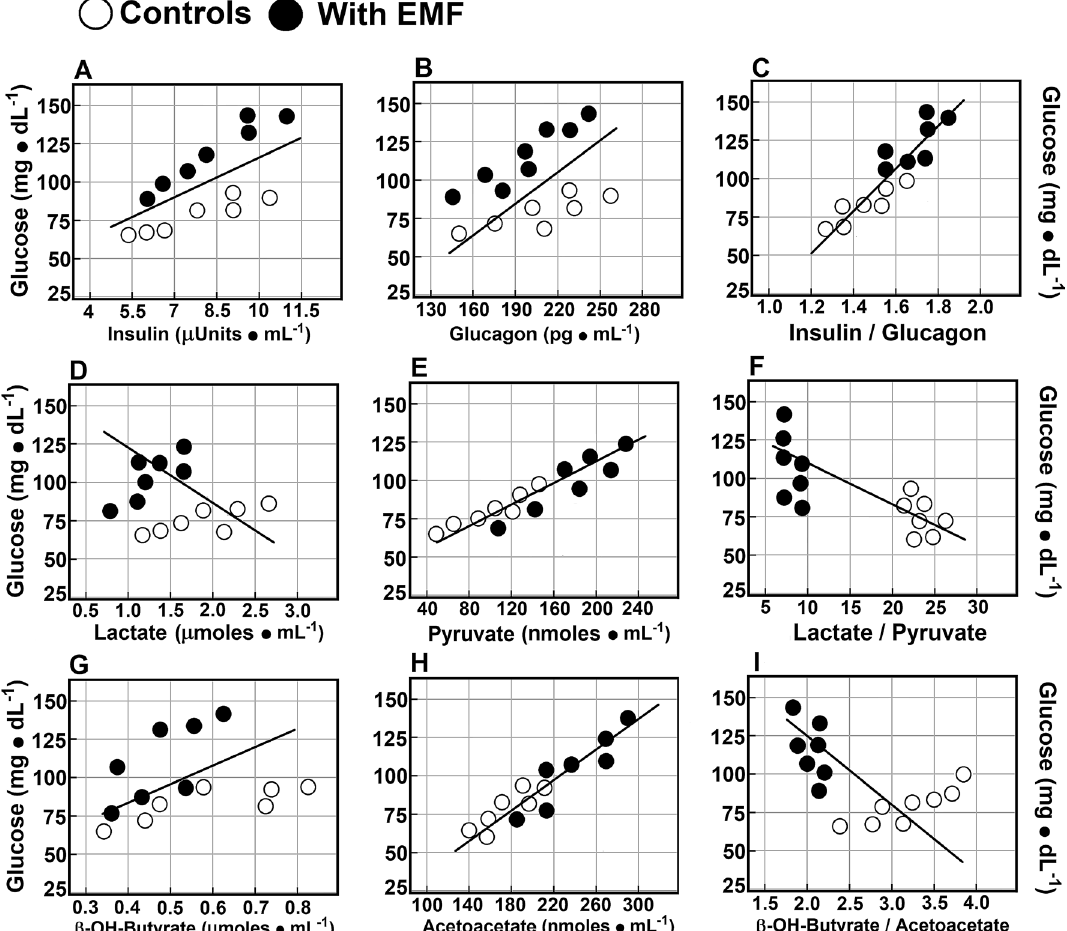
Figure 5. Correlations among serum glucose levels, insulin, glucagon, and redox-pair metabolites. Scatter plots show the relation between two sets of data. This relation is summarized in the Pearson’s correlation coefficient (r) for each relation in each scatter plot: panel A, glucose vs. insulin levels (r = 0.687, p < 0.01), panel B: glucose vs. glucagon levels (r = 0.403, p < 0.05), and panel C, glucose against the insulin/glucagon ratio (r = 0.965, p < 0.001). Panel D shows correlations of glucose vs. lactate levels (r = − 0.132, n.s.), panel E, glucose against pyruvate levels (r = 0.993, p < 0.001), and panel F, glucose levels vs. the lactate/pyruvate ratio (r = − 0.806, p < 0.001). Finally, glucose against β-OH-but levels (r = 0.146, n.s) in panel G, panel H, glucose vs. AcAc levels (r = − 0.963, p < 0.001), and panel I, glucose levels against the β-OH-but/AcAc ratio (r = − 0.584, p <